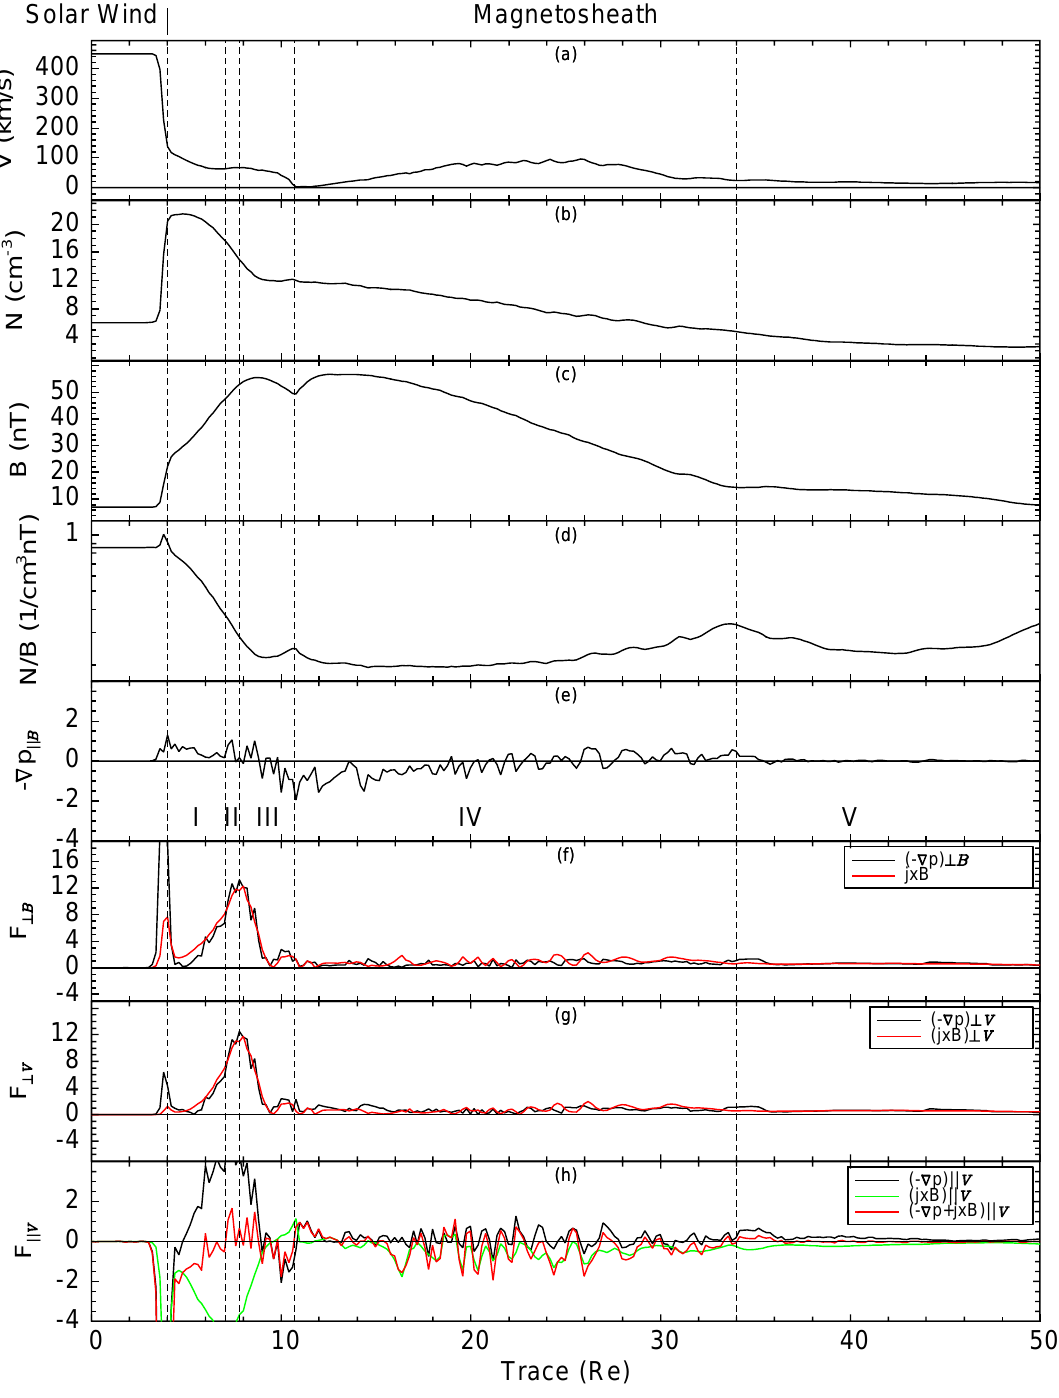
Fig. 12. Forces in a streamline coordinate system along streamline 0 in the right panel of Fig. 8, together with plasma and field parameters. The display is the same as in Fig.